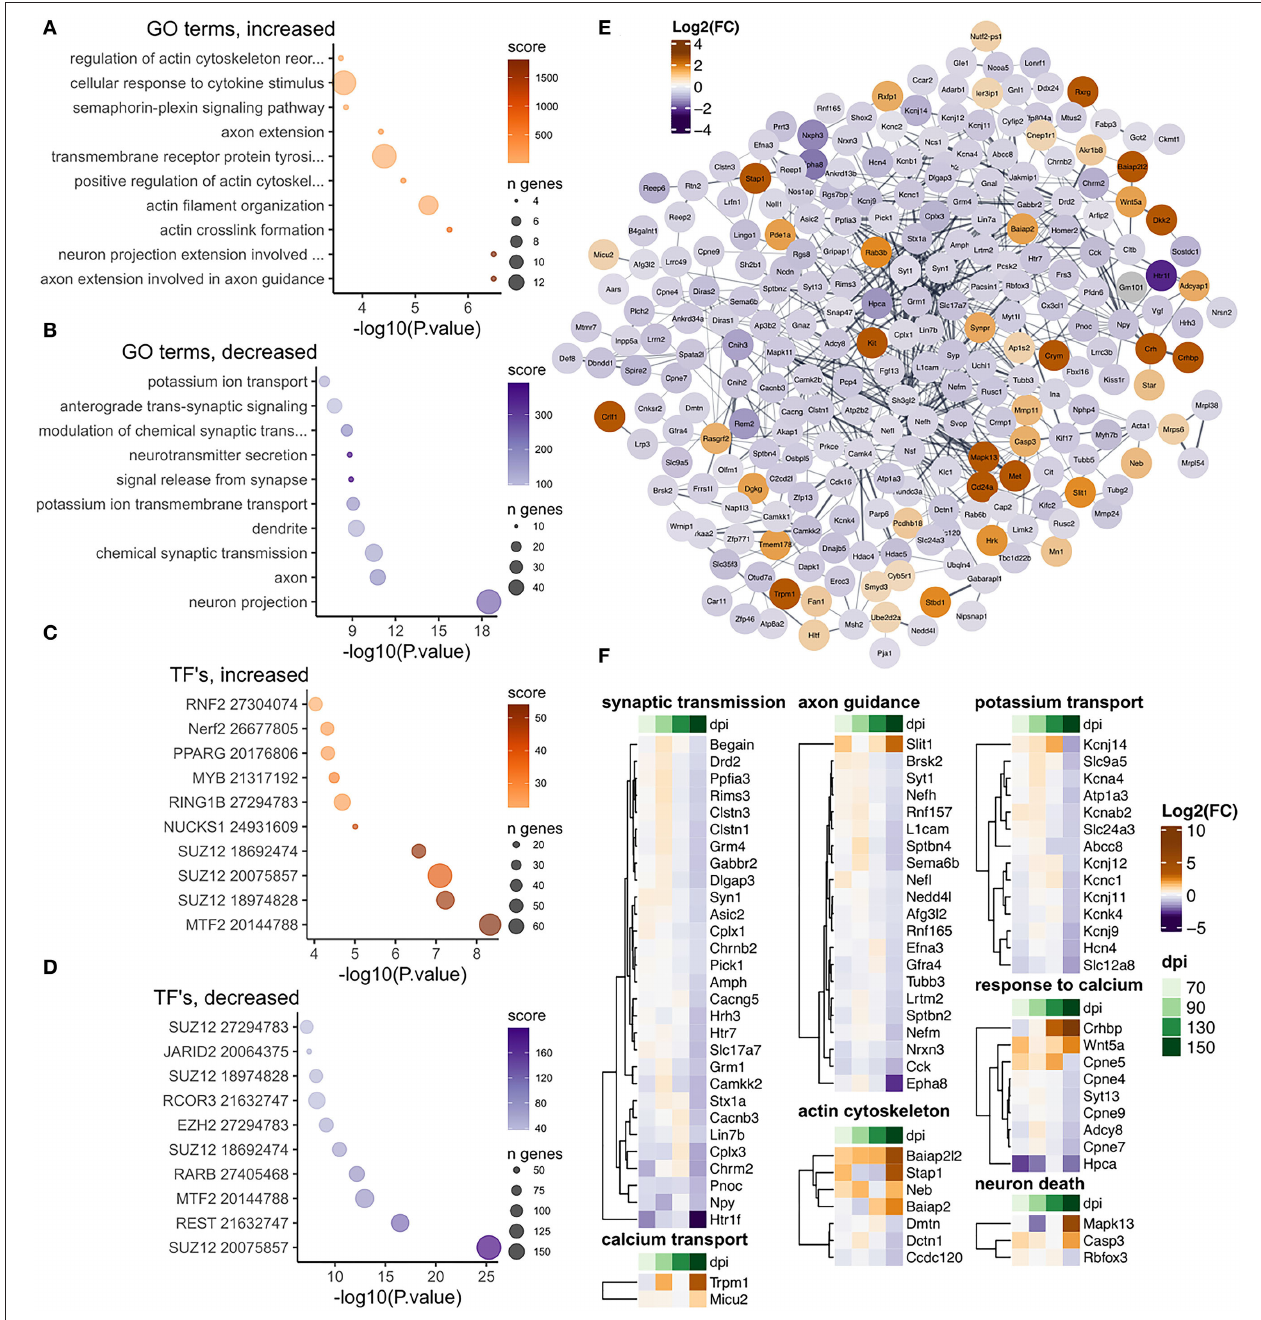
FIGURE 6 | Transcriptional changes affiliated with thalamus neurons in RML infected mice at 150 dpi. Enrichr was used to identify enriched gene ontologies for thalamus neuron affiliated transcripts that were (A) increased and (B) decreased during RML disease. Enriched transcription factors were also identified for (C) increased and (D) decreased transcripts. (E) STRING was used to construct a protein-protein interaction network of the 366 prion altered thalamus neuron transcripts. (F) Heatmaps were used to visualize magnitude of change, expressed as log 2 fold-changes at each timepoint for notable thalamus neuron transcripts that were categorized as related to synaptic transmission, calcium transport, axon guidance, actin cytoskeleton, potassium transport, response to calcium, and neuron death.